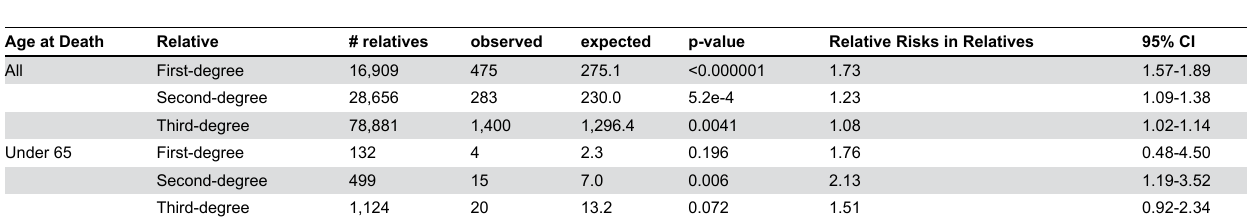
Table 2. Estimated Relative Risks for death from Alzheimer’s disease among first, second and third degree relatives of individuals dying from Alzheimer’s disease, separated by those dying before age 65, and those dying at all ages.